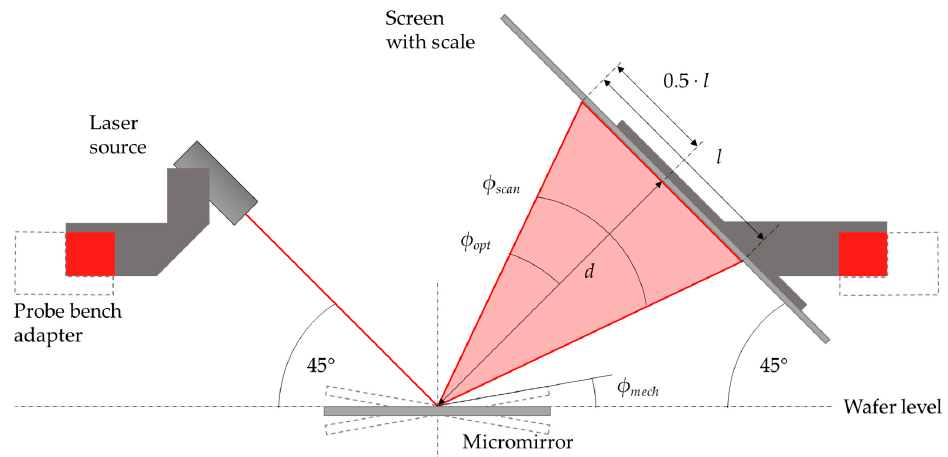
Figure 11. Schematic of the optical test setup. The laser beam and screen were aligned in a defined distance at a 45 ° angle to the mirror. The illustrated scan angle, optical angle, and mechanical tilt angle could be calculated with (2) and (3).